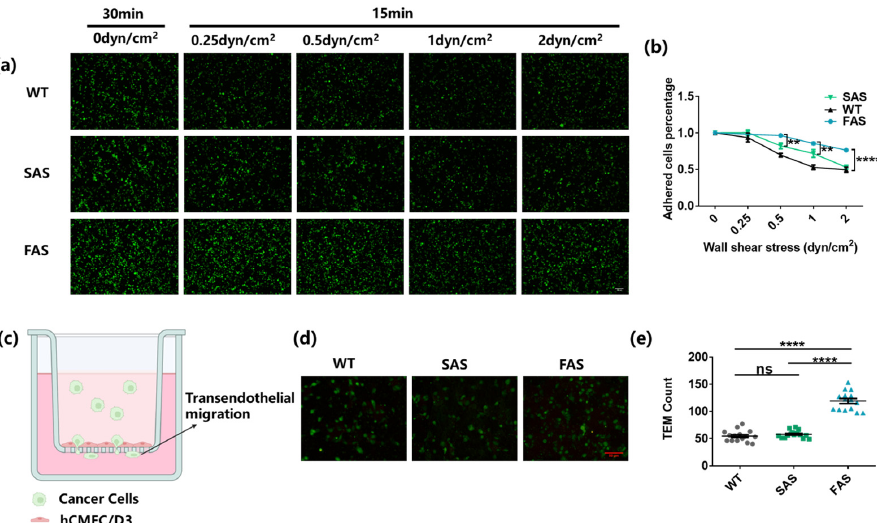
Figure 3. FAS cells exhibit enhanced adhesion to the brain endothelium and BBB transmigration ability. ( a , b ) FAS cells exhibited enhanced adhesion strength on the endothelium. All groups were labeled with green cell tracker and added into the fl ow chamber slides to adhere to the brain endothelium for 30 min. Then, 0.25, 0.5, 1, and 2 dyn/cm 2 wall shear stress were applied to each slide for 15 min, respectively. The cancer cells remaining on the brain endothelium after each treatment of fl uid shear stress were counted using the fl uorescence microscope. Two-way ANOVA along with post hoc Tukey test were used to calculate the statistics. Scale bar = 100 µm. n = 3. ( c ) The illustration of trans-endothelial migration assay (created by biorender.com). ( d , e ) FAS cells exhibited enhanced BBB transmigration ability. An hCMEC/D6 monolayer was cultured on the top of the insert membrane and cancer cells were added to transmigrate through the monolayer to the lower chamber. The transmigrated cancer cells (marked by the green cell tracker) were imaged and counted using fl uorescence microscopy. One-way ANOVA along with post hoc Bonferroni test was performed to analyze the statistics. Scale bar = 50 µm. n = 3. All data are represented by mean ± SEM. (ns: no signi fi cance, ** p < 0.01, **** p < 0.0001).